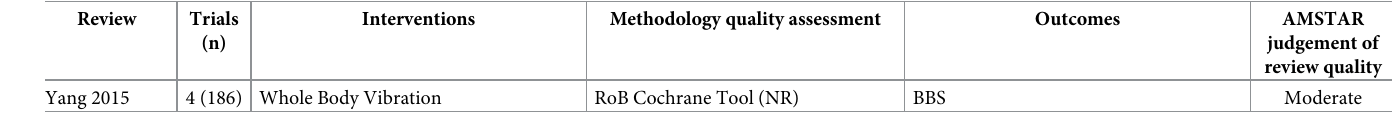
( S2 Table) . See S3 Table for the complete list of all included SRs, and trials included in these SRs, which have contributed to this overview. See S4 Table for the characteristics of the included SRs, including full details of the participants, interventions, comparisons and out- comes. No study reported any adverse events of rehabilitation